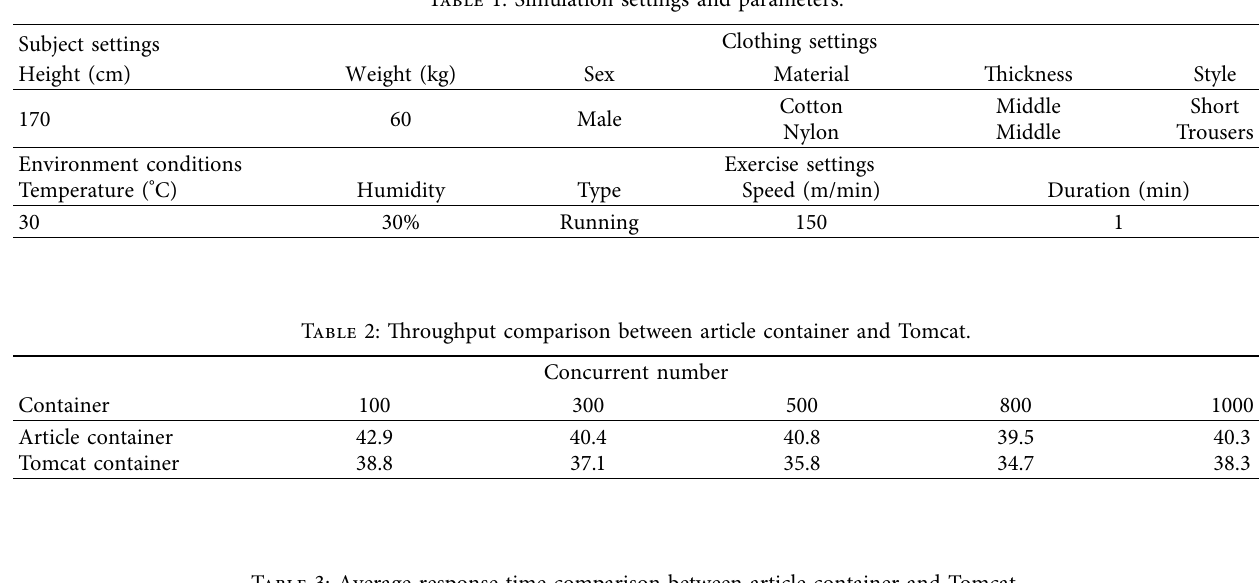
Table 1: Simulation settings and parameters.